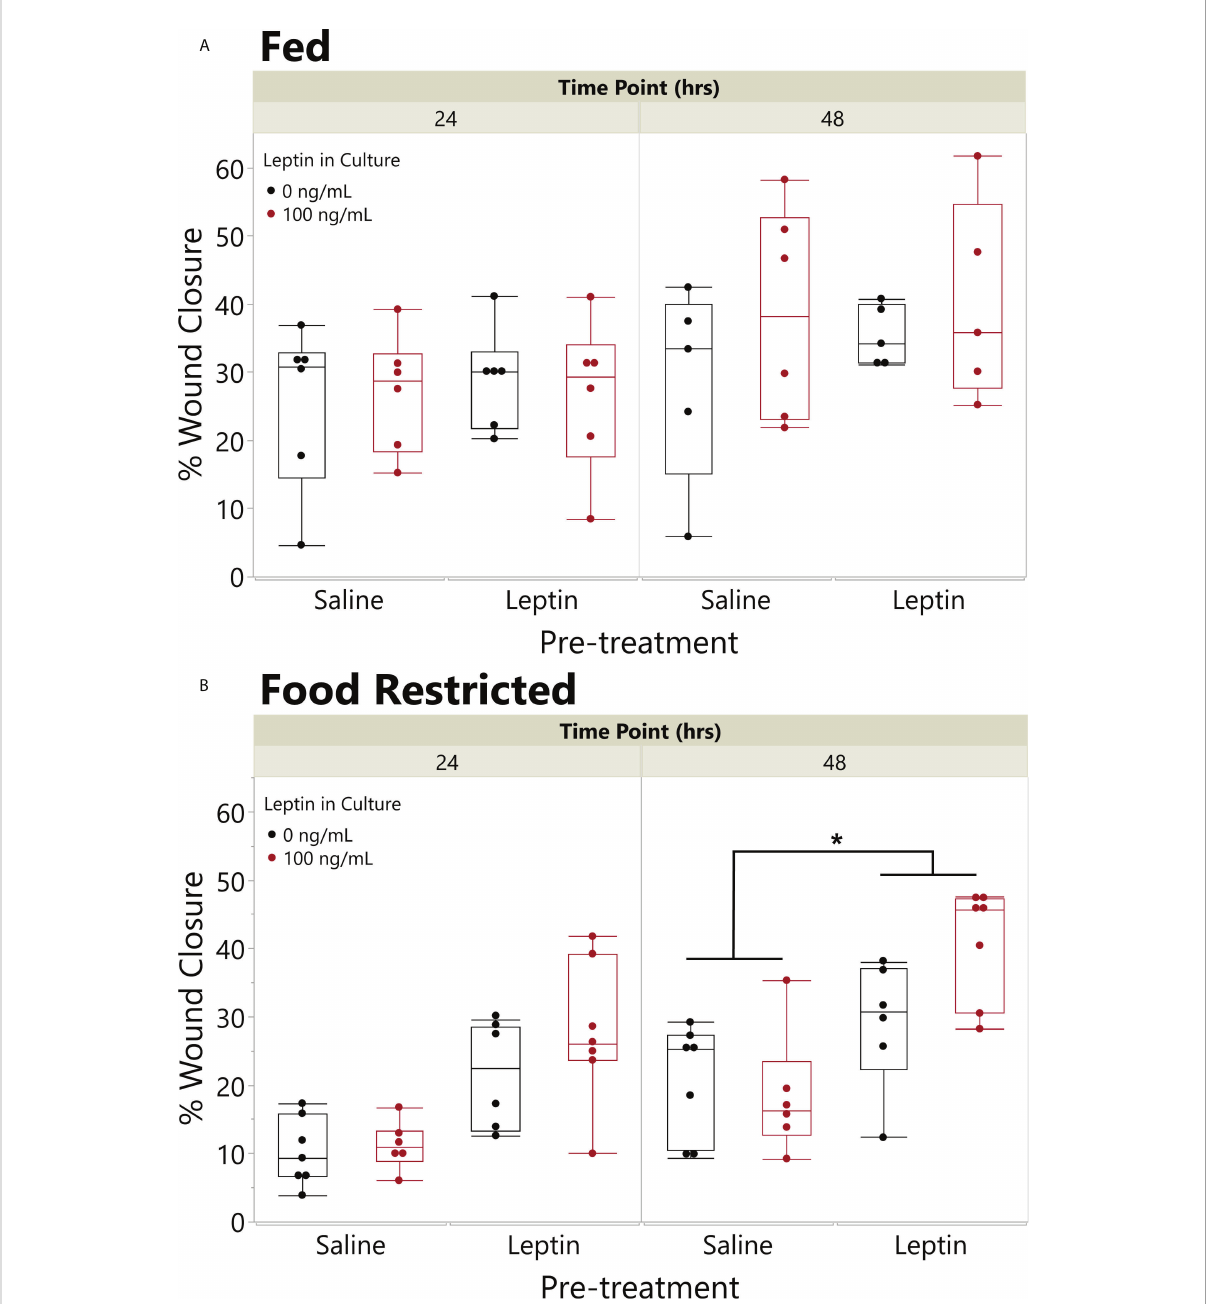
FIGURE 6 Pretreatment with leptin rescues effect of food restriction on wound closure in vitro . Effect of leptin on in vitro wound healing of juvenile Xenopus laevis dorsal skin explants where animals were fed (A) once a day or (B) food restricted for 31 days and then injected in the peritoneum (IP) with leptin (200 ng/g body weight) or saline every other day for 7 days. Dorsal skin donut explant wounds were then treated with (black) or without leptin (red) in culture (100 ng/ml) for 48 h. Pretreatment with IP leptin injection signi fi cantly increased the rate of wound closure in food-restricted animals over those with pretreatment injections of saline by 48 h, but there was no effect of pretreatment injection in fed animals (ANOVA, fed status * injection, p = 0.0253); asterisk indicates signi fi cant increase in wound healing in leptin pretreated vs. saline pretreated explants (Tukey ’ s HSD, p < 0.05, n = 8/treatment). There was no signi fi cant effect of leptin in the culture media (black vs. red) in this model (p =